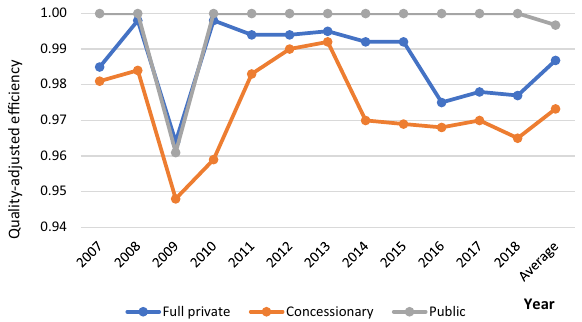
Fig. 3 Evolution over time of quality-adjusted ef fi ciency of Chilean full private, concessionary, and public water utilities. The trend in quality-adjusted ef fi ciency based on the type of water utility.